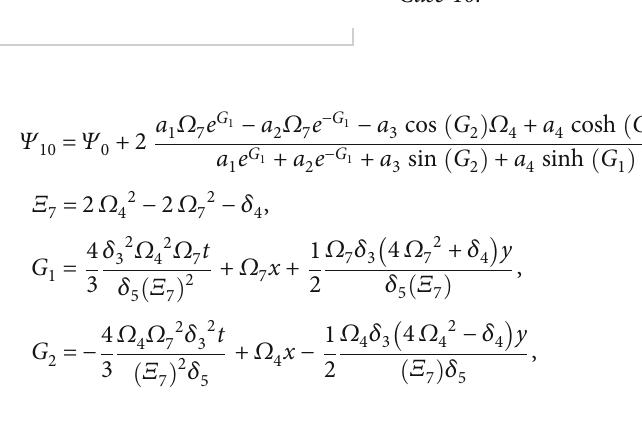
= 1 : 2, δ = 1, δ = 1 : 3, 4 1 2